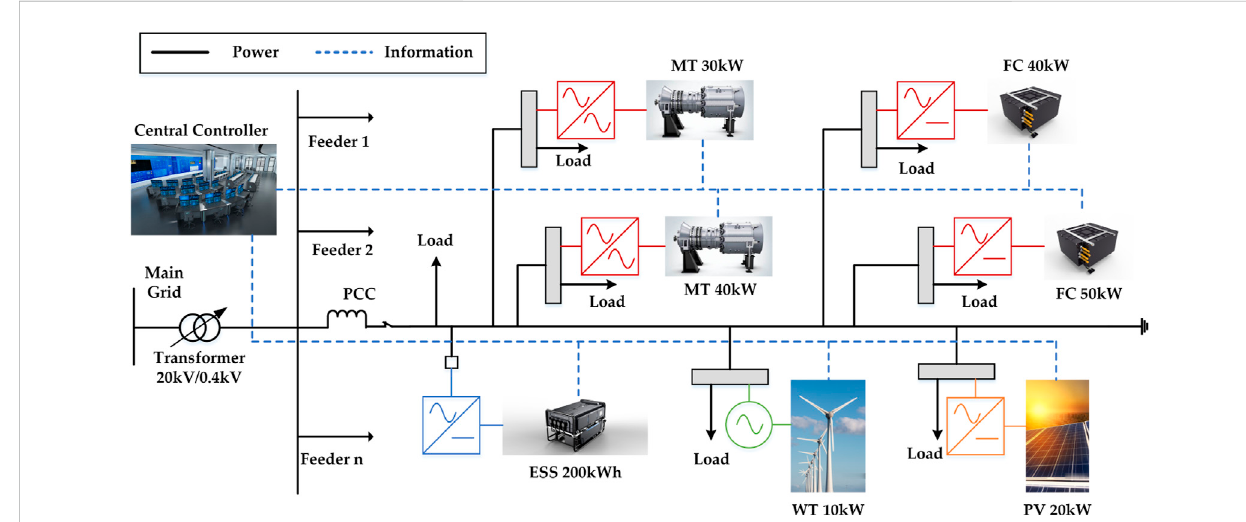
FIGURE 6 Schematic of the framework for of fl ine training and online operation.